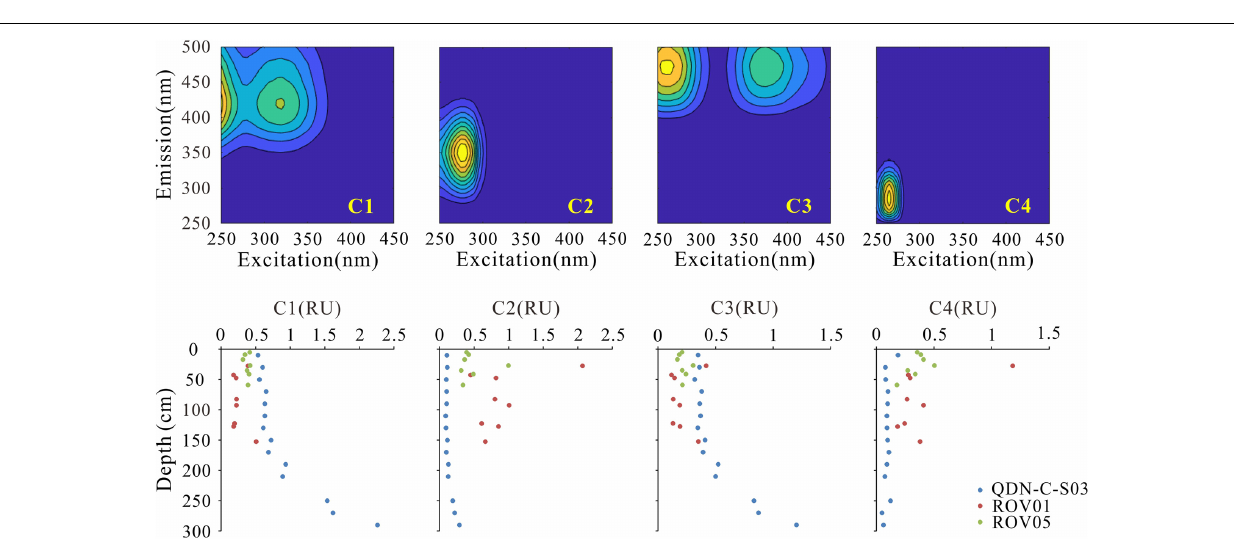
of the average DOC concentrations at QDN-C-S03 and ROV1 are 0.44 and 1.70 mM, we estimated that 41 and 77% of DOC pool are composed of fluorescence material at QDN-C-S03 and ROV1, respectively. The negative intercept value at ROV5 may imply a contribution of dissolved organic sulfur to FDOM